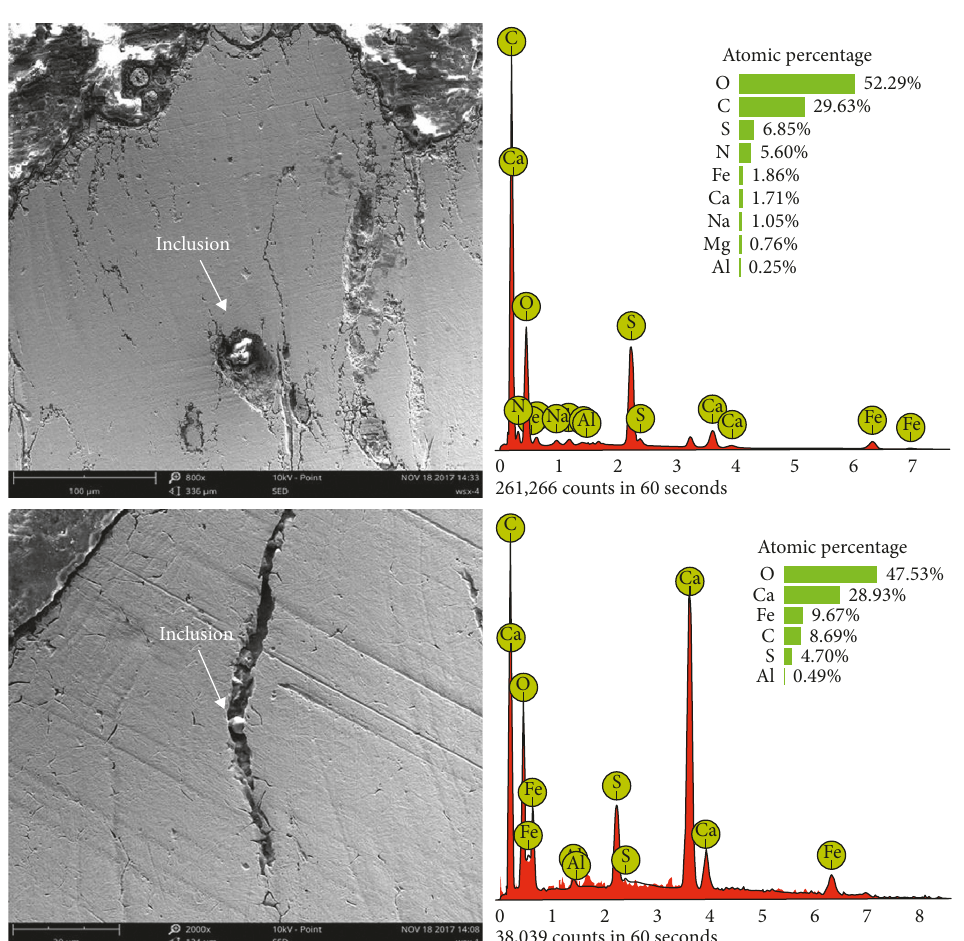
Figure 8: Chemical compositions of the inclusion particles.